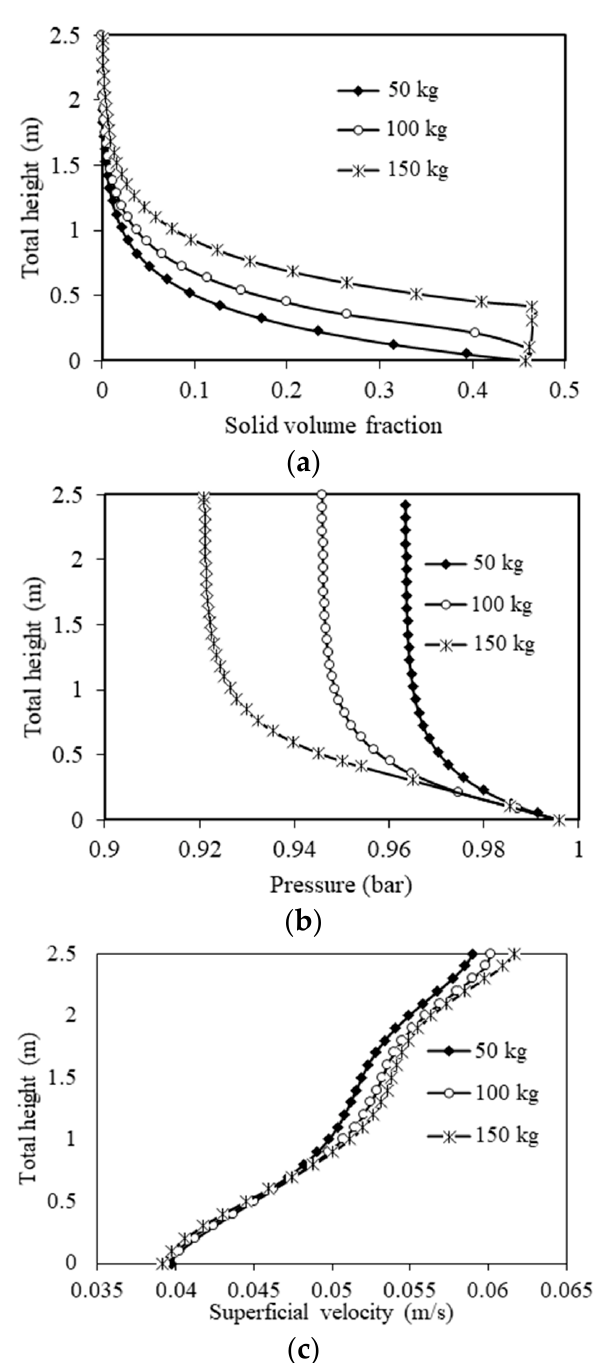
Figure 7. ( a ) Solid volume fraction distributions, ( b ) pressure distribution, and ( c ) superficial velocity, along the gasifier for a bed mass inventory of 50 kg, 100 kg, and 150 kg.